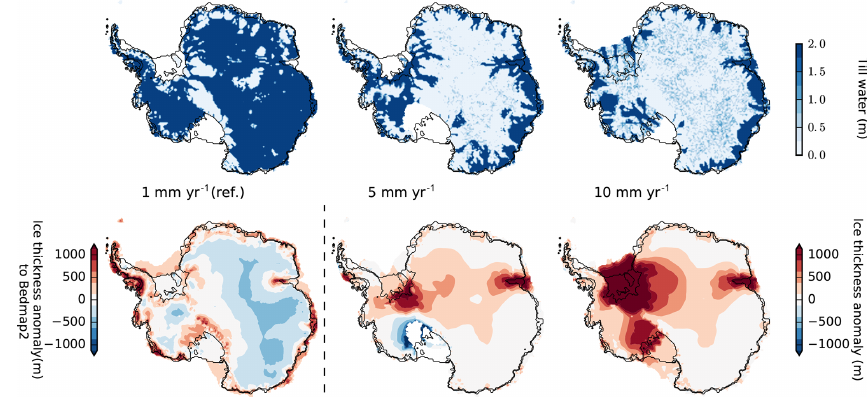
Figure 16. Present-day result of glacial-cycle simulation, showing ice thickness anomaly in Bedmap2 (lower left) or in reference for different till water decay rates (from left to right: 1, 5 and 10mmyr − 1 ), causing different till water distributions underneath the ice sheet (upper row). For a reference decay rate of 1mmyr − 1 about 90% of ice sheet’s bed is saturated, while for 10mmyr − 1 saturated till is only found in the coastal regions and underneath the fast-flowing ice stream.